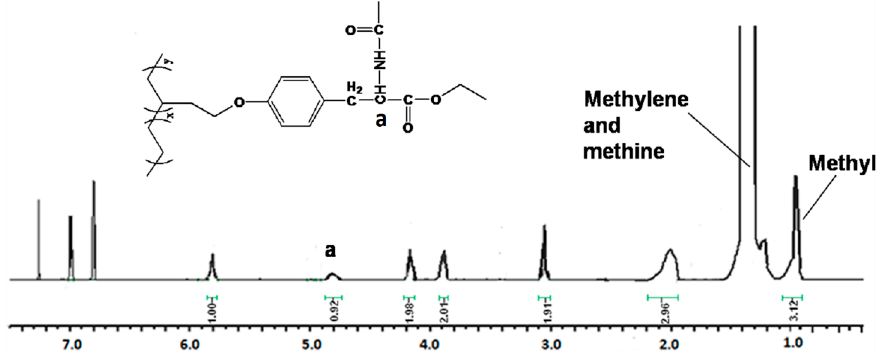
Figure 6. 1 H NMR spectrum of the copolymer of ethylene/ N -acetyl- O -(but-3-enyl)- L -tyrosine ethyl ester from run 3 in Table 2.